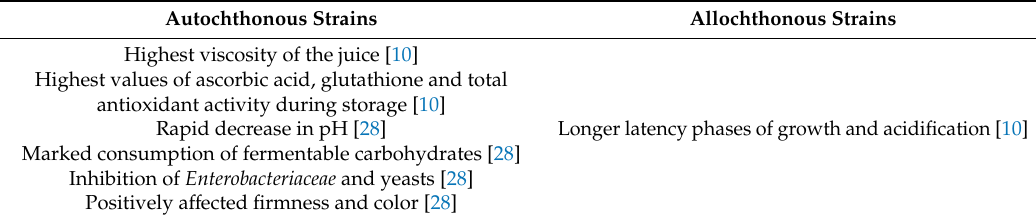
Table 3. Properties of autochthonous and allochthonous